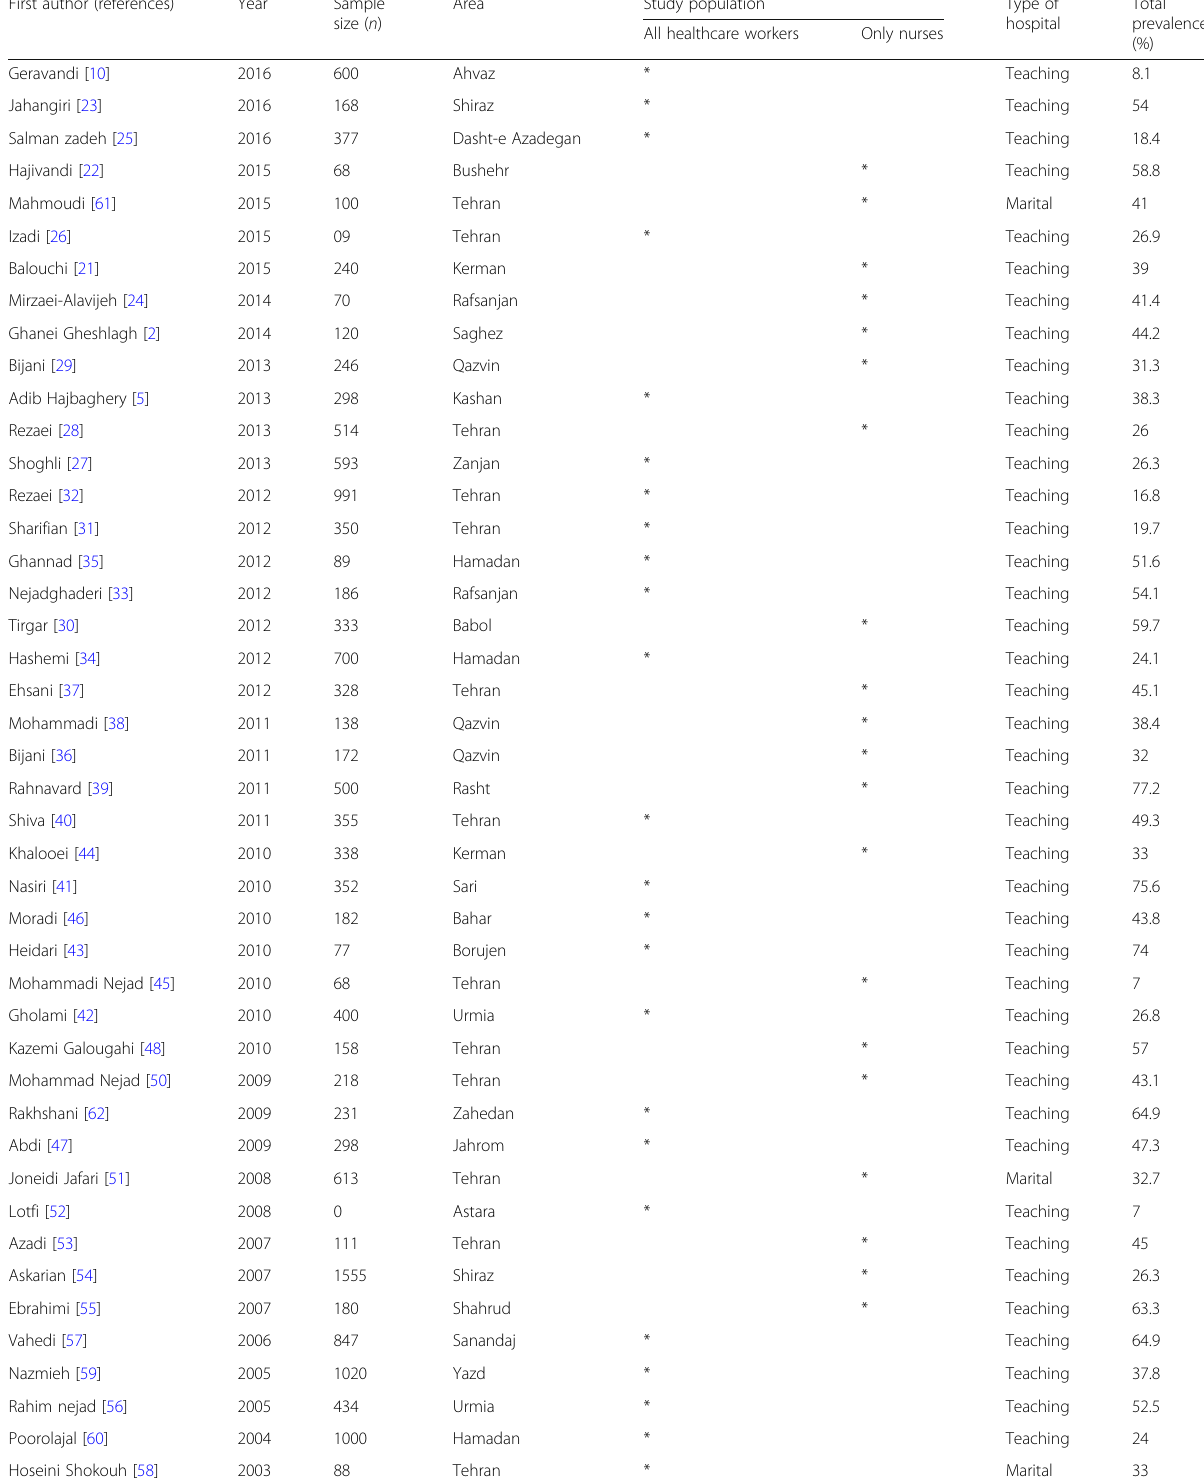
Table 1 Characteristics of selected